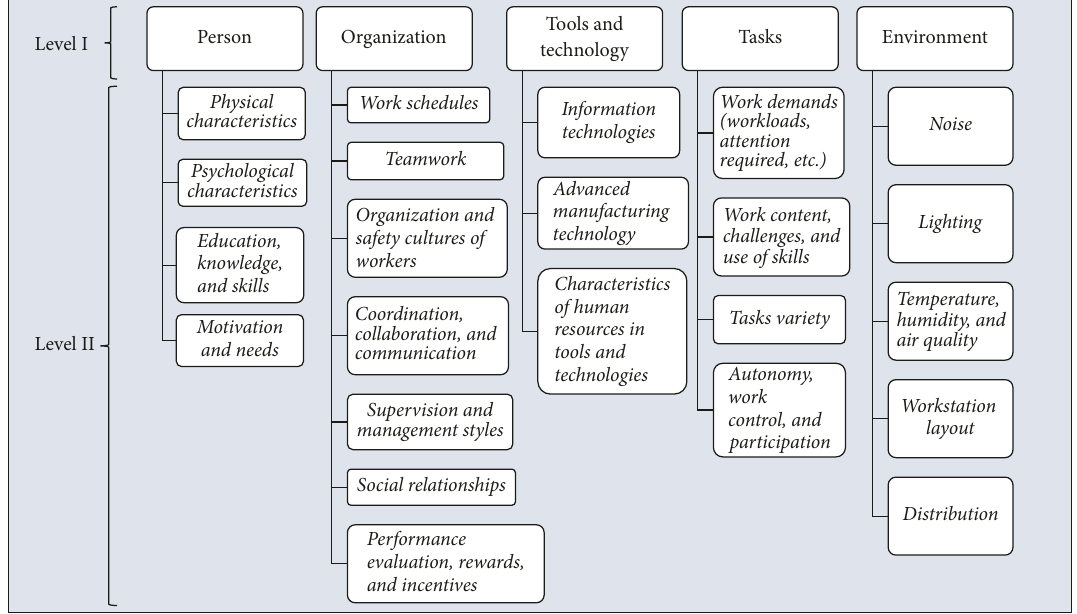
Figure 2: Macroergonomic factors and